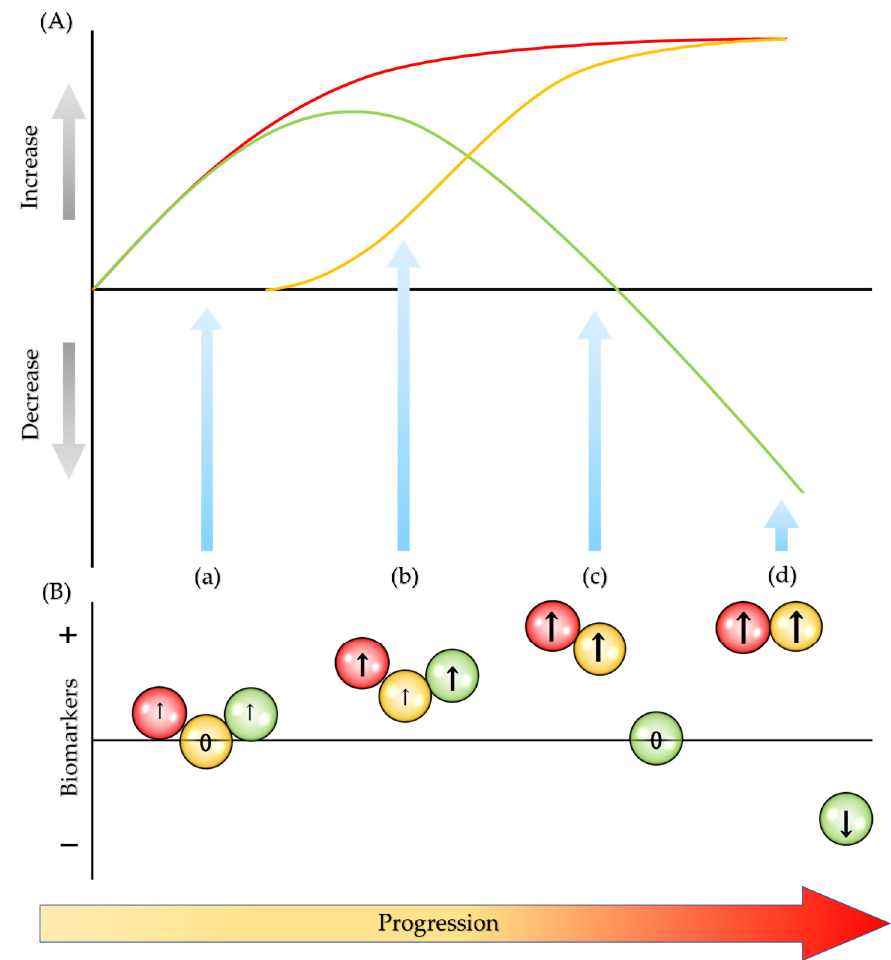
Figure 4. Dynamics of redox components in disease progression. ( A ) – (red line): reactive chemical species and activities of oxidative enzymes increase gradually. – (orange line): the degradation products increase accordingly upon exhaustion of antioxidative enzymes’ activities. – (green line): antioxidative enzymes offset the effects of oxidative enzymes in the early phase, however; the antioxidative activities decline and, finally, fatigue in the later phase, resulting in the exacerbation of inflammation and cellular damage. ( B ) Biomarkers of three redox components may present different values. (a) The levels of oxidative enzyme slightly increase, but the degradation markers stay in a normal range. The antioxidative markers also slightly increase. (b) The oxidative markers further elevate, and the degradation markers start slightly increasing. The antioxidative markers also stay elevated. (c) The oxidative enzyme markers increase, but antioxidative markers return to normal range. The degradation product markers further elevate. (d) The oxidative markers greatly increase, but the antioxidative markers decline. The degradation products markers greatly elevate.